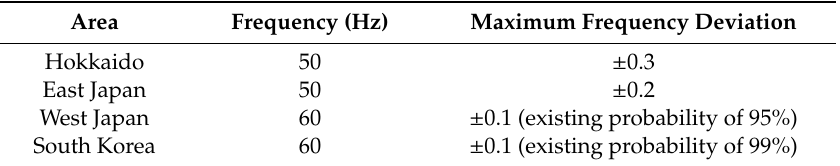
Table 1. Regulation target of frequency